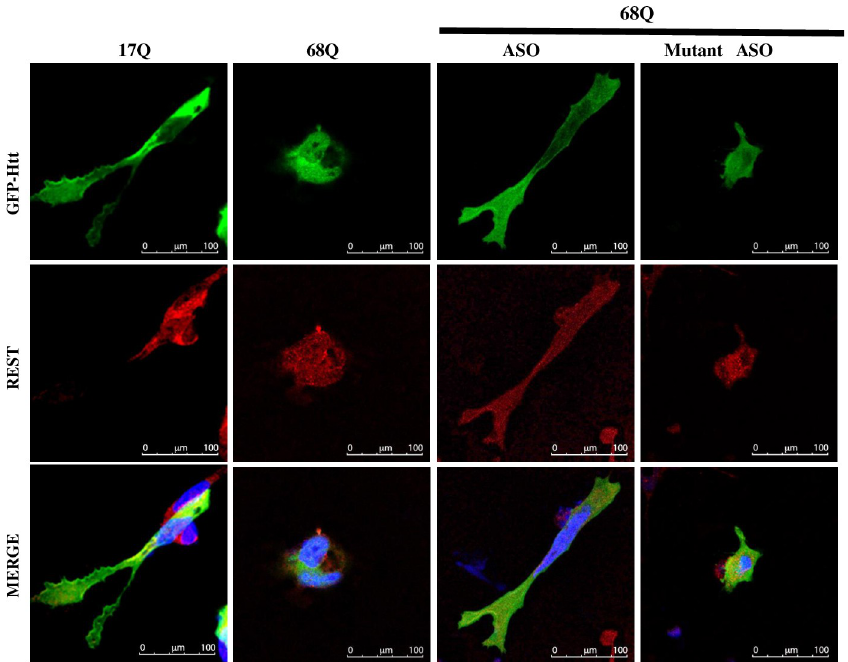
Fig 7. Inhibition of the expression or activity of Hsp90, rescues of the cell death to differentiated cells and transfected with mutant Htt. Differentiated SH-SY5Y cells transfected with expression vectors GFP-480-17Q or GFP- 480-68Q (fluorescence green), for 24 h. REST in red and DNA stained DAPI (blue). Cells transfected with expression vector GFP-480-68Q or co-transfected with Hsp90 mutant ASO showed signs of neurodegeneration and early apoptosis events including morphological changes, membrane blebbing, cell shrinkage, shorter neurites, and sometimes more fragmented nuclei compared with GFP-480-17Q. Antisense oligos against Hsp90 (ASO) decreased the levels of mHtt and REST in the nucleus, and GA or PUH-71 presented similarly behavior; decreased mHtt and REST level, and they had protective effects against mHtt toxicity. A population of at least 300 co-transfected cells, with expression vector GFP-480-17Q or GFP-480-68Q and Hsp90-ASO, were analyzed and the image shown is representative of them.